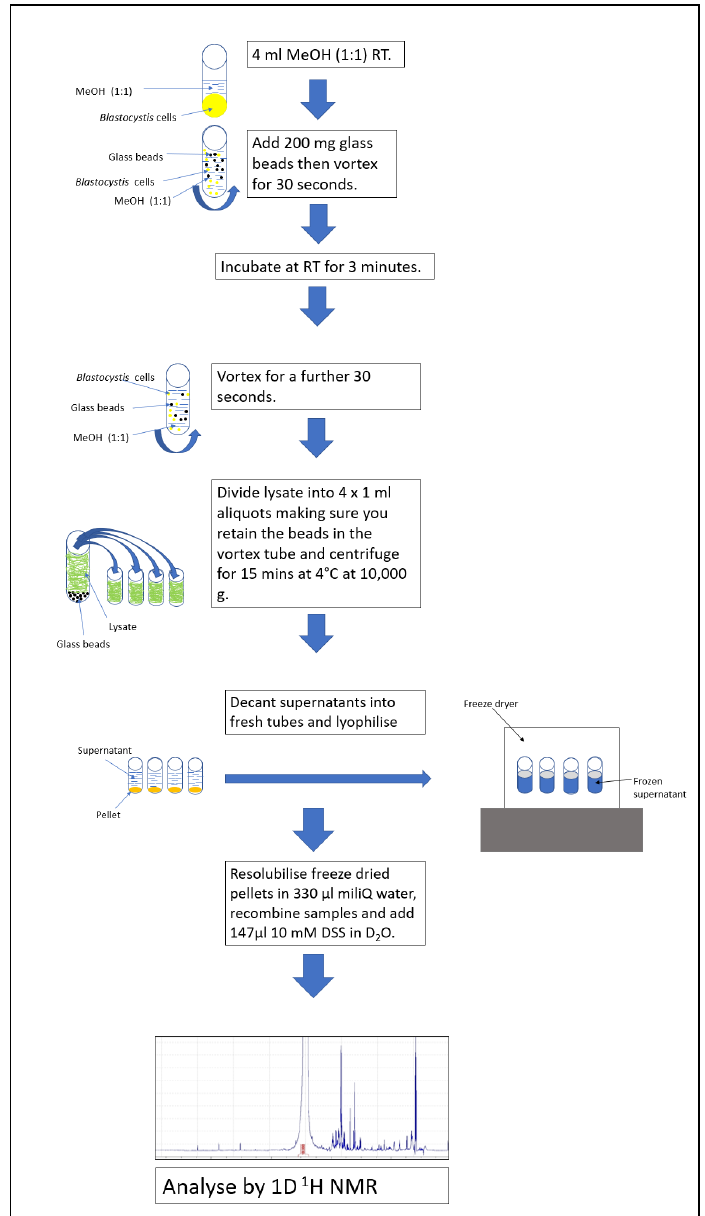
Figure 4. Final metabolite extraction protocol optimised by this study. Methanol is used as the extraction solvent, bead bashing as the lysis technique and incubation at RT.